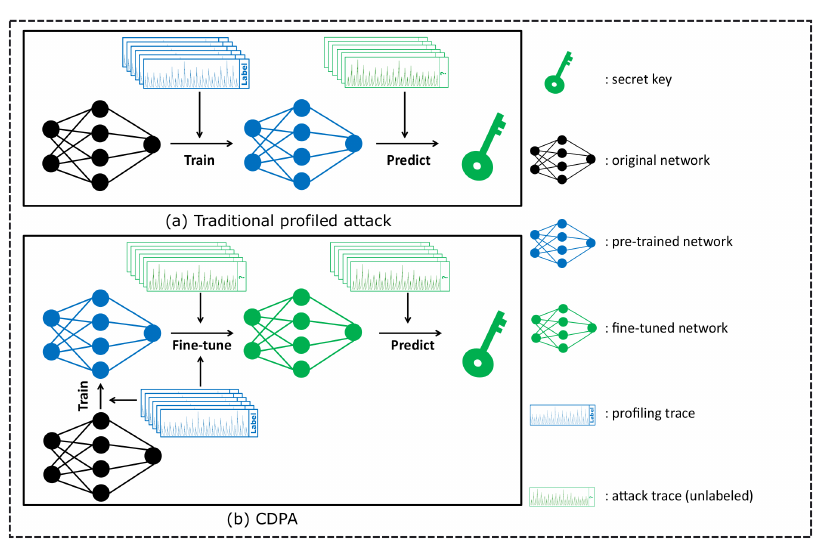
Figure 3: Comparison of traditional profiled attack and